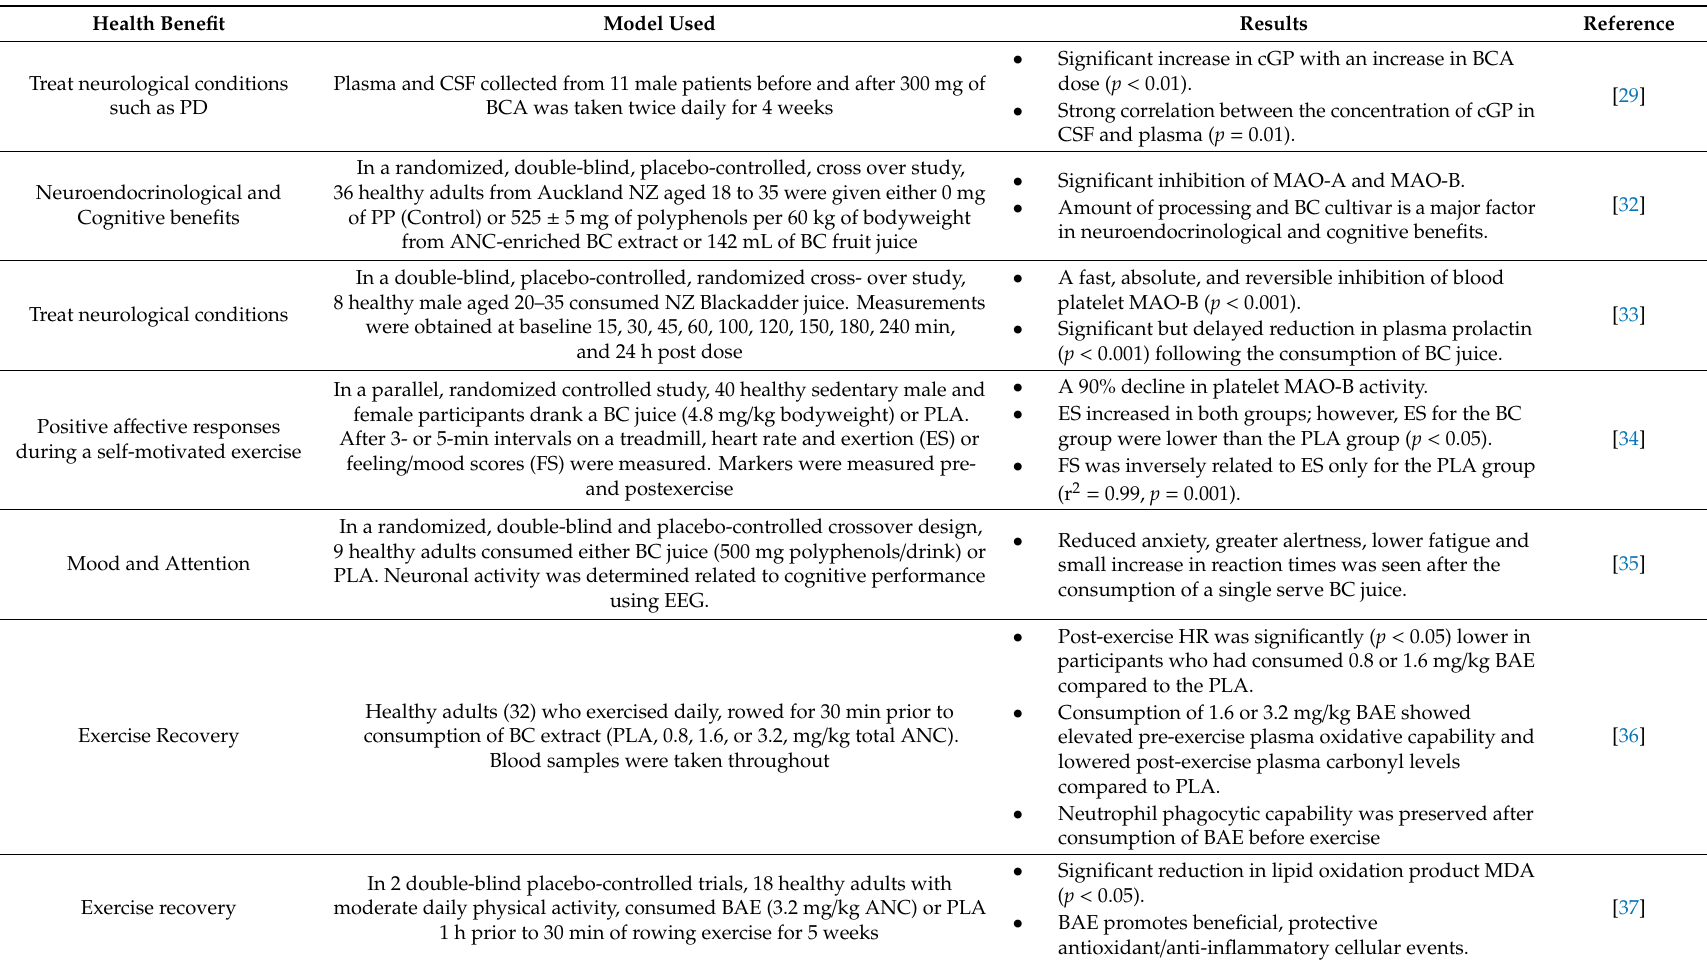
Table 3. Health benefits of blackcurrants based on human